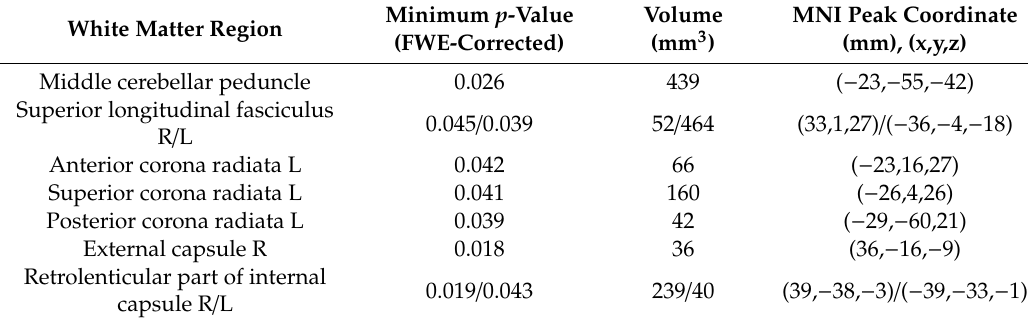
Table A7. White matter regions from the ICBM-DTI-81 White Matter Atlas for which significant increased RTPP values were found in CM compared to EM including the duration of the migraine, presence of aura and medication overuse headache as